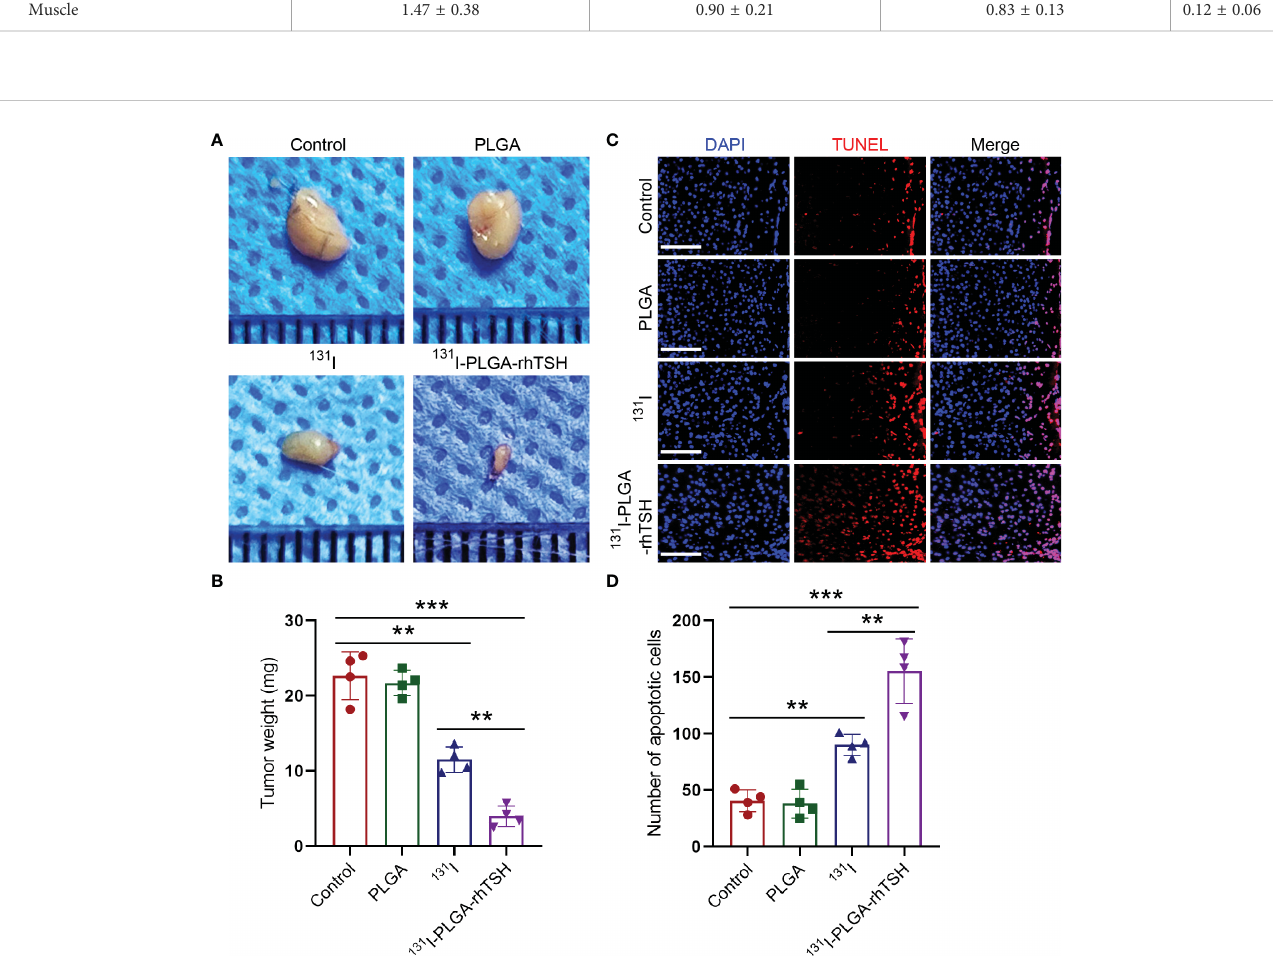
FIGURE 4 The application of 131 I-PLGA-rhTSH nanoparticles reduced tumor size through inducing apoptosis in thyroid cancer. (A) The representative images illustrating the tumor size in each group. (B) A summarized bar graph presenting the tumor weight from (A) . n = 4 each group, ** p < 0.01, *** p < 0.001; one-way ANOVA, followed by Tukey ’ s post hoc test. (C) The typical images revealing the number of apoptotic cells in each group. Scale bars: 20 m m. (D) Summarizing bar graph illustrating the number of apoptotic cells from (C) . n = 4 each group, ** p < 0.01, *** p < 0.001; one-way ANOVA, followed by Tukey ’ s post hoc